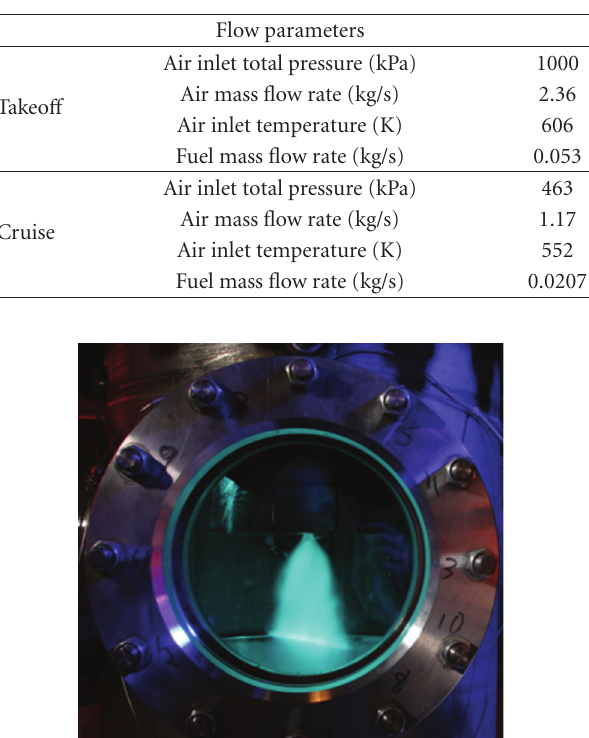
Table 1: Engine operating conditions.